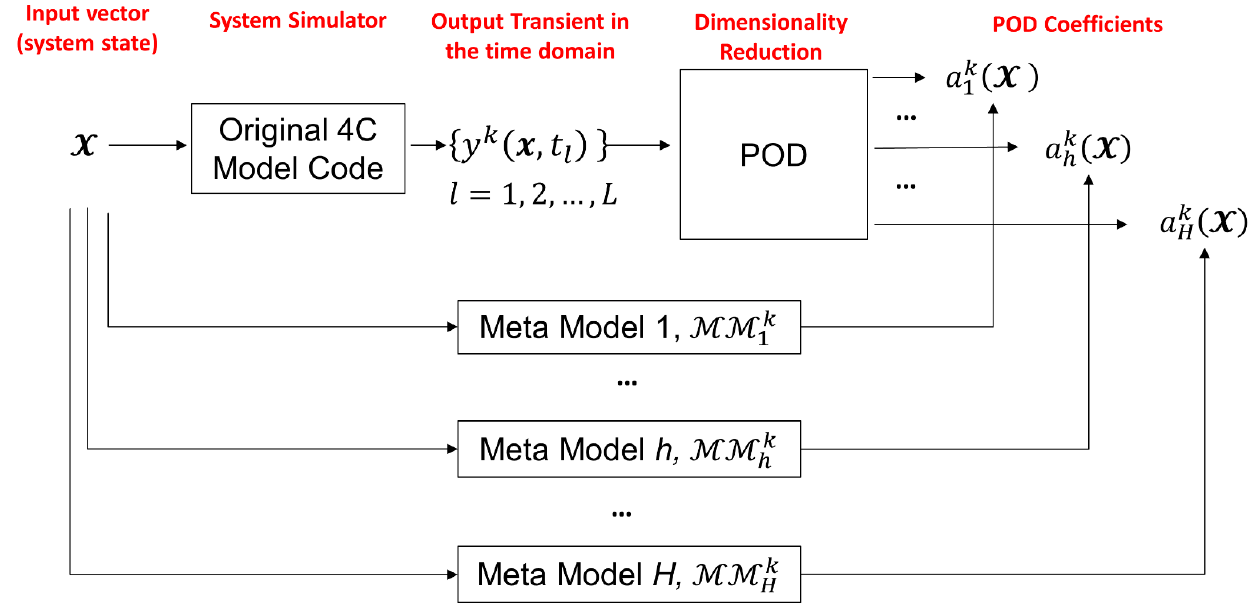
Figure 4. Conceptual steps undertaken to construct the POD-based Kriging metamodels.